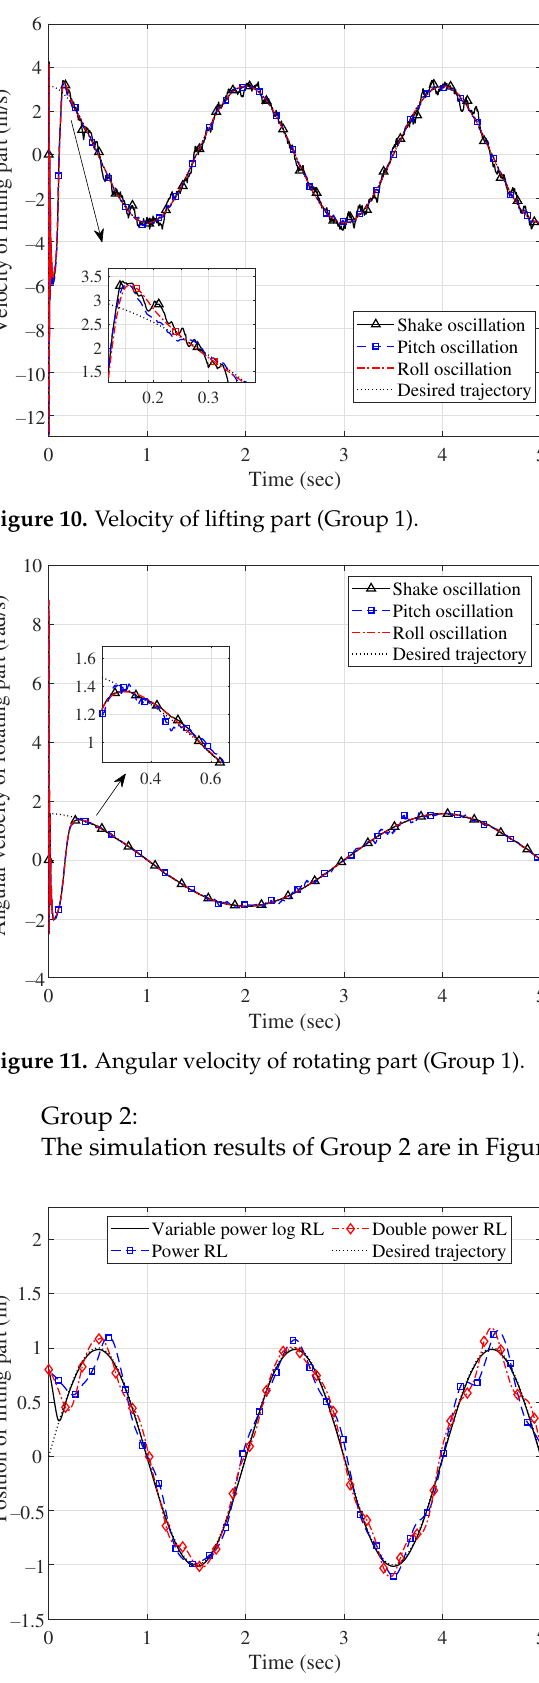
Figure 12. Position of lifting part (Group